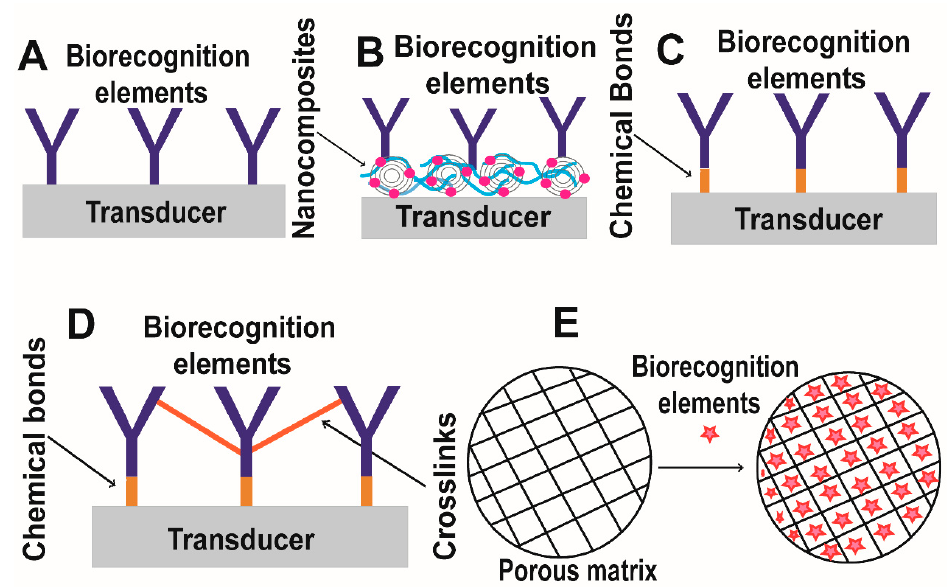
Figure 4. Illustrated scheme of event when physically adsorbing biomolecules on the surface of ( A ) transducer; ( B ) nanocomposites-modified transducer; ( C ) covalently attaching biorecognition elements on the transducer; ( D ) crosslinking between biorecognition elements and the transducer; and ( E ) biorecognition elements entrapment in polymer matrix.